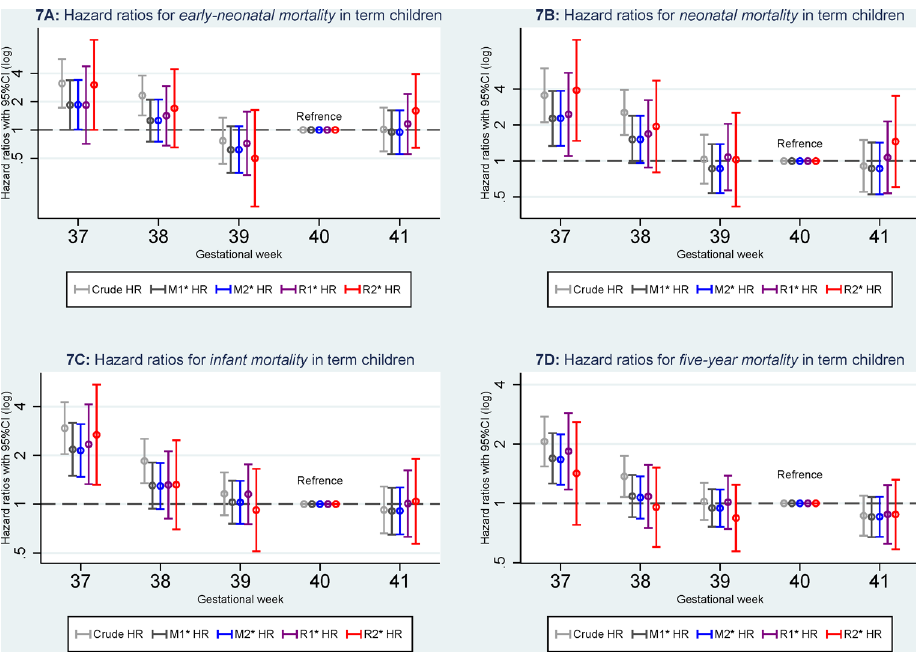
Fig 7. Hazard ratios for mortality according to gestational age in weeks. M1: Model 1, the results were adjusted for caesarean section (yes or no), maternal age ( < 25, 25 – 30, 30 – 35, > = 35), parity (1, 2, and 3), and birth year (1997 – 1999, 2000 – 2002, 2003 – 2005, and 2006 – 2008). M2: model 2, the results were additionally adjusted for maternal education (low, middle, and high) and maternal cohabitant status during birth (yes, no). R1: Restricted analyses 1, the analyses were restricted to pregnancies without registered morbidity within one year before delivery or within 30 days after delivery using the same adjustments in Model 2. R2: Restricted analyses 2: the analyses were further restricted to pregnancies without registered morbidity within one year before delivery or within 30 days after delivery and children without any registered congenital malformations using the same adjustments in Model